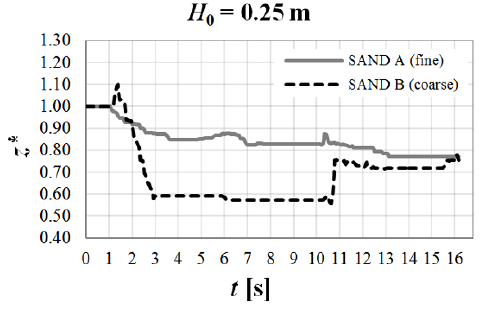
Figure 8. Experimental time evolution of z * at the dike downstream reference abscissa (+ δ ) for Tests A2 and B2.